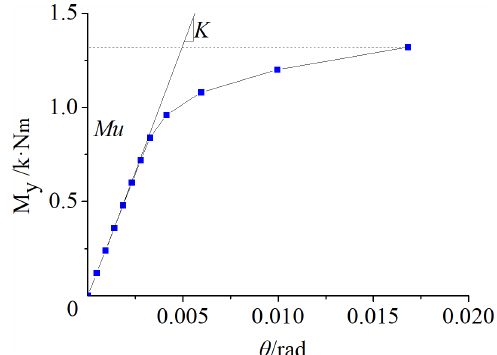
Figure 10: Moment-rotation curve of angle joint